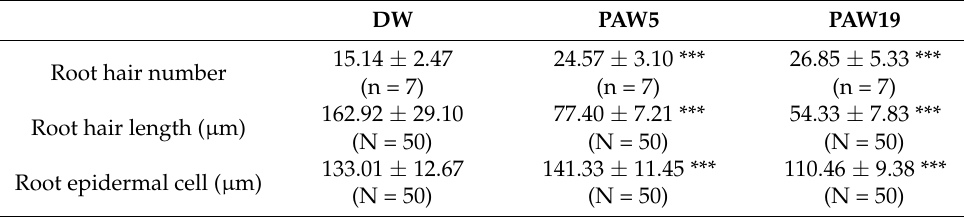
Table 5. Root hair number and length of A. thaliana L. (WER::GFP / cobl9-1) grown for 7 days after planting.